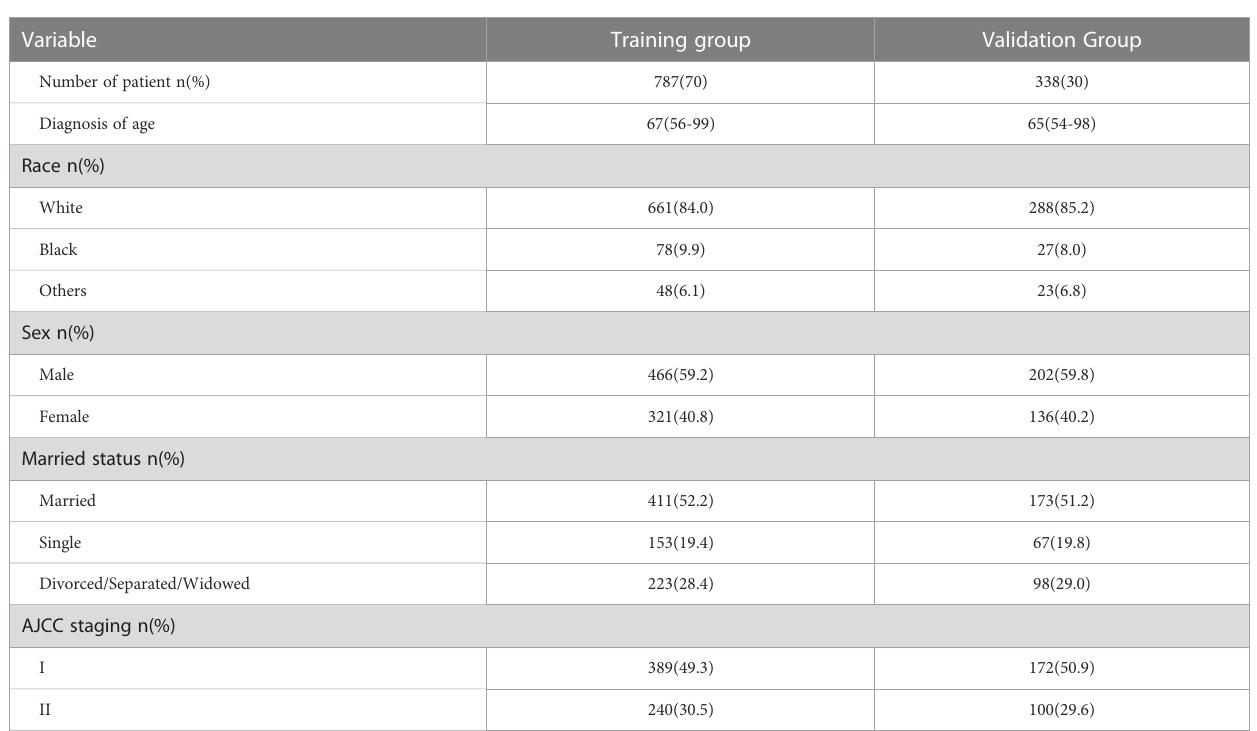
TABLE 1 Patient characteristics and